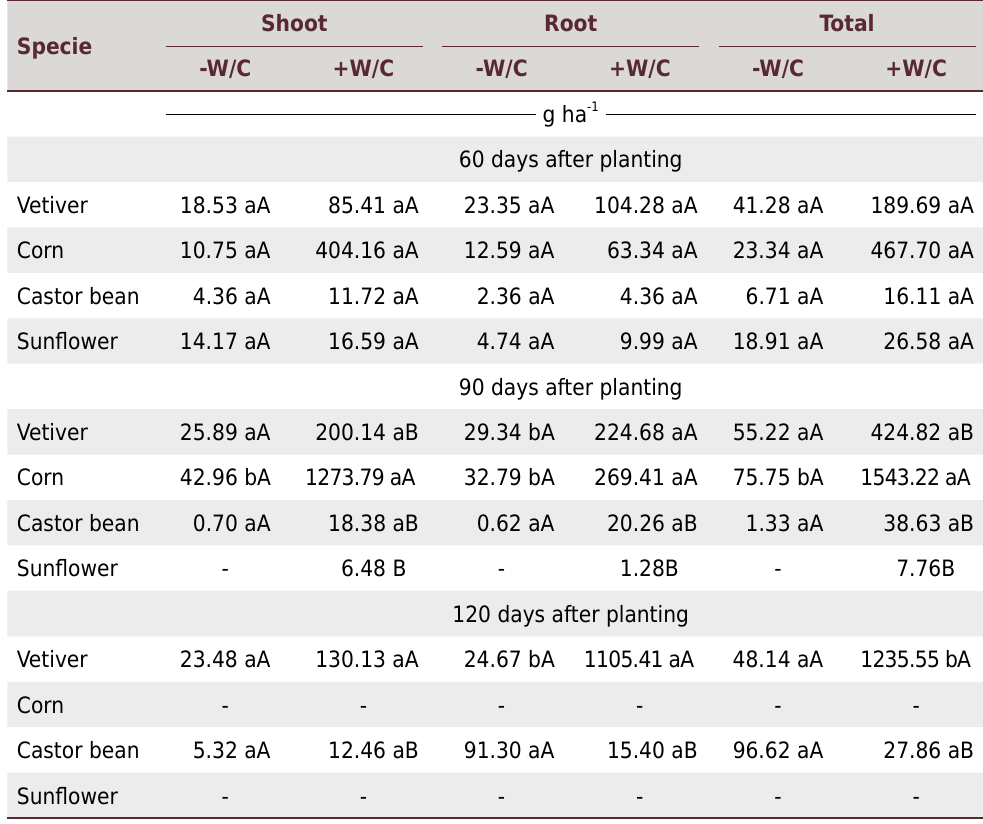
Table 2. Lead accumulation by the shoots, roots, and total (roots + shoots) for vetiver, corn, castor bean, and sunflower species obtained in different evaluation periods, without (-W/C) and with (+W/C) correction of soil pH (mean of four replications)